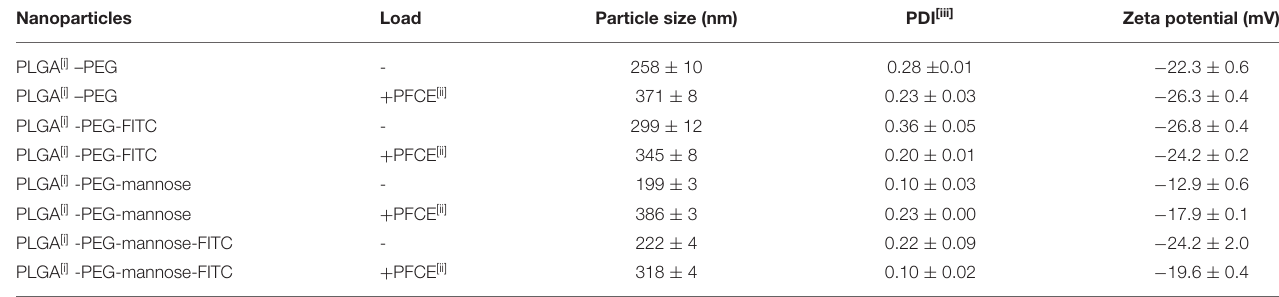
TABLE 2 | Particle Size, PDI, and Zeta potential of PLGA-PEG nanoparticles.